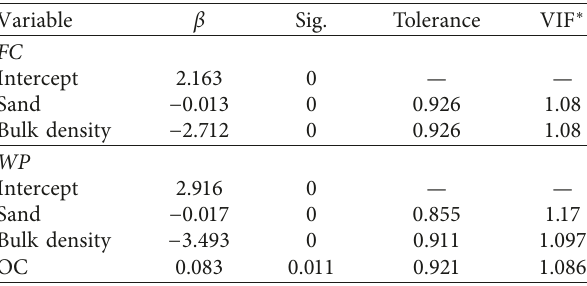
Table 5: β coefficients of MLR-PTFs for FC and WP.